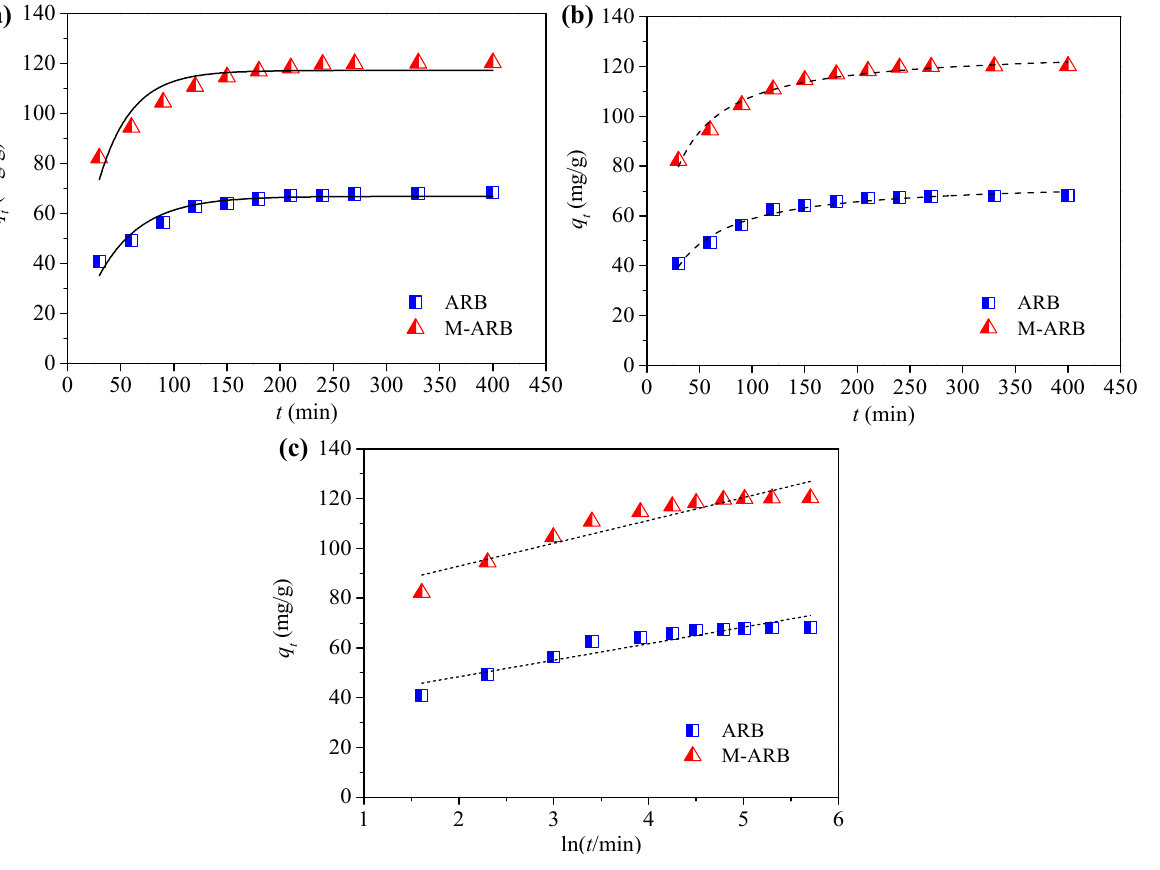
Figure 7. Adsorption kinetics fitting of MB onto ARB and M-ARB: ( a ) quasi-primary kinetic model, ( b ) quasi-secondary kinetic model, and ( c ) Elovich model.